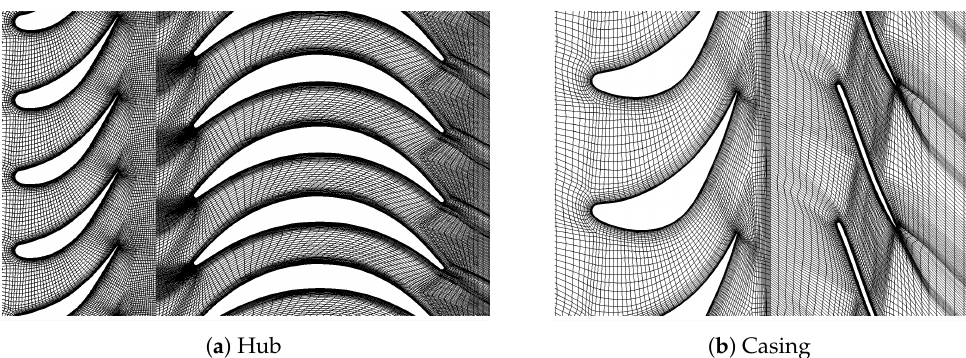
Figure 2. Mesh resolution near hub and casing. Every other grid line is shown.